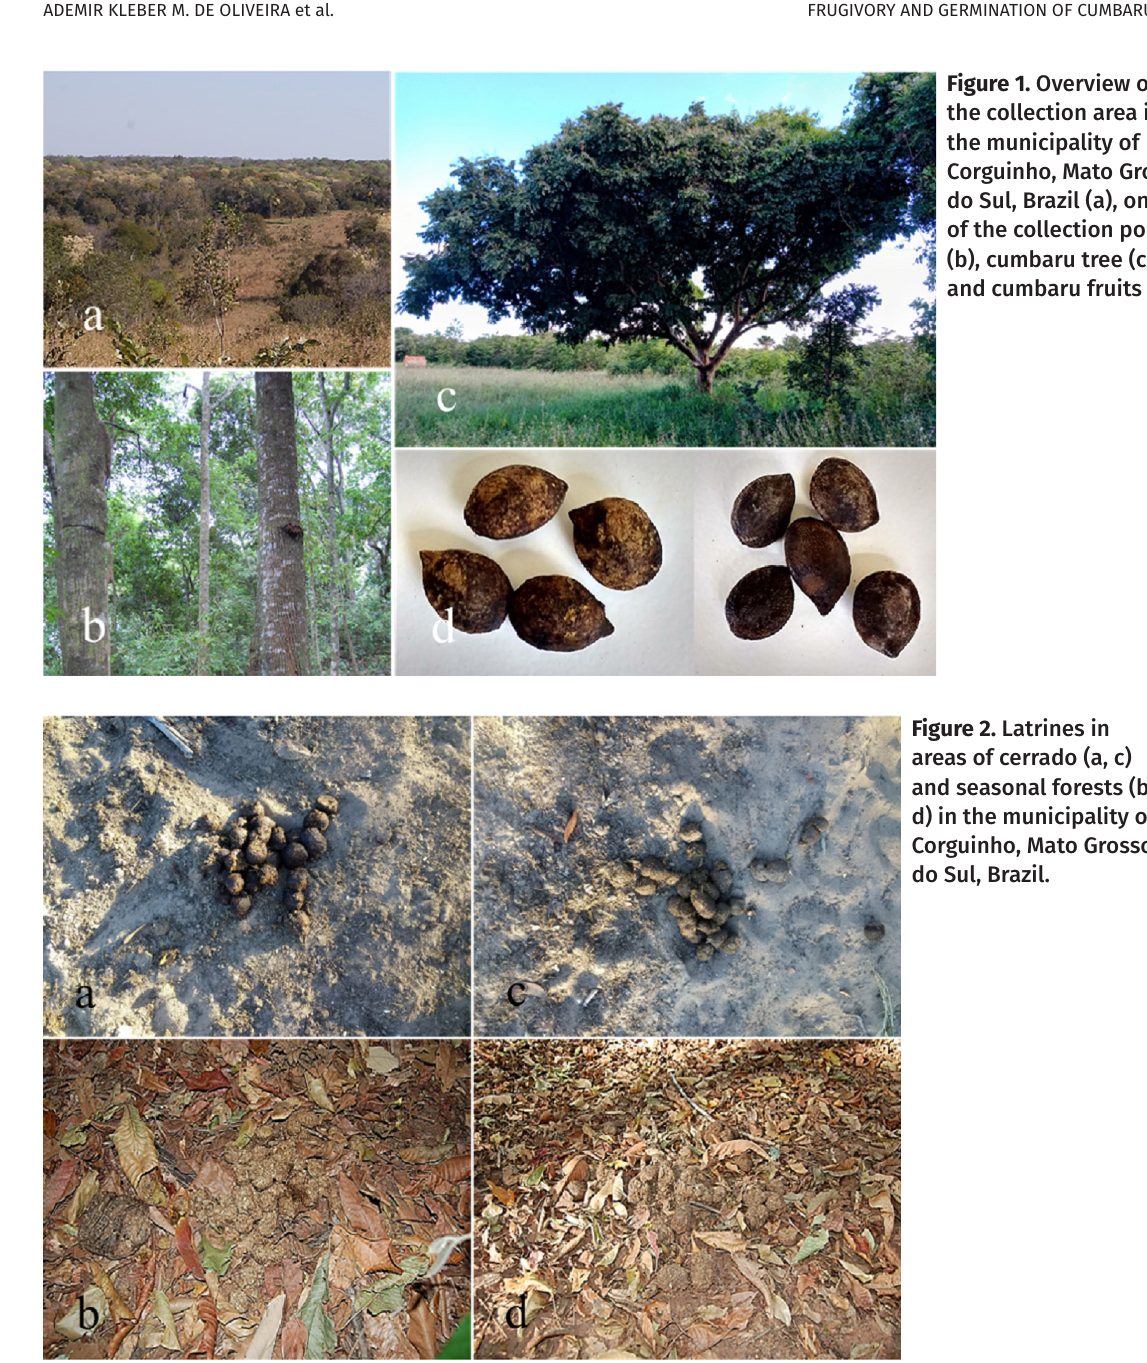
Figure 2. Latrines in areas of cerrado (a, c) and seasonal forests (b, d) in the municipality of Corguinho, Mato Grosso do Sul, Brazil.